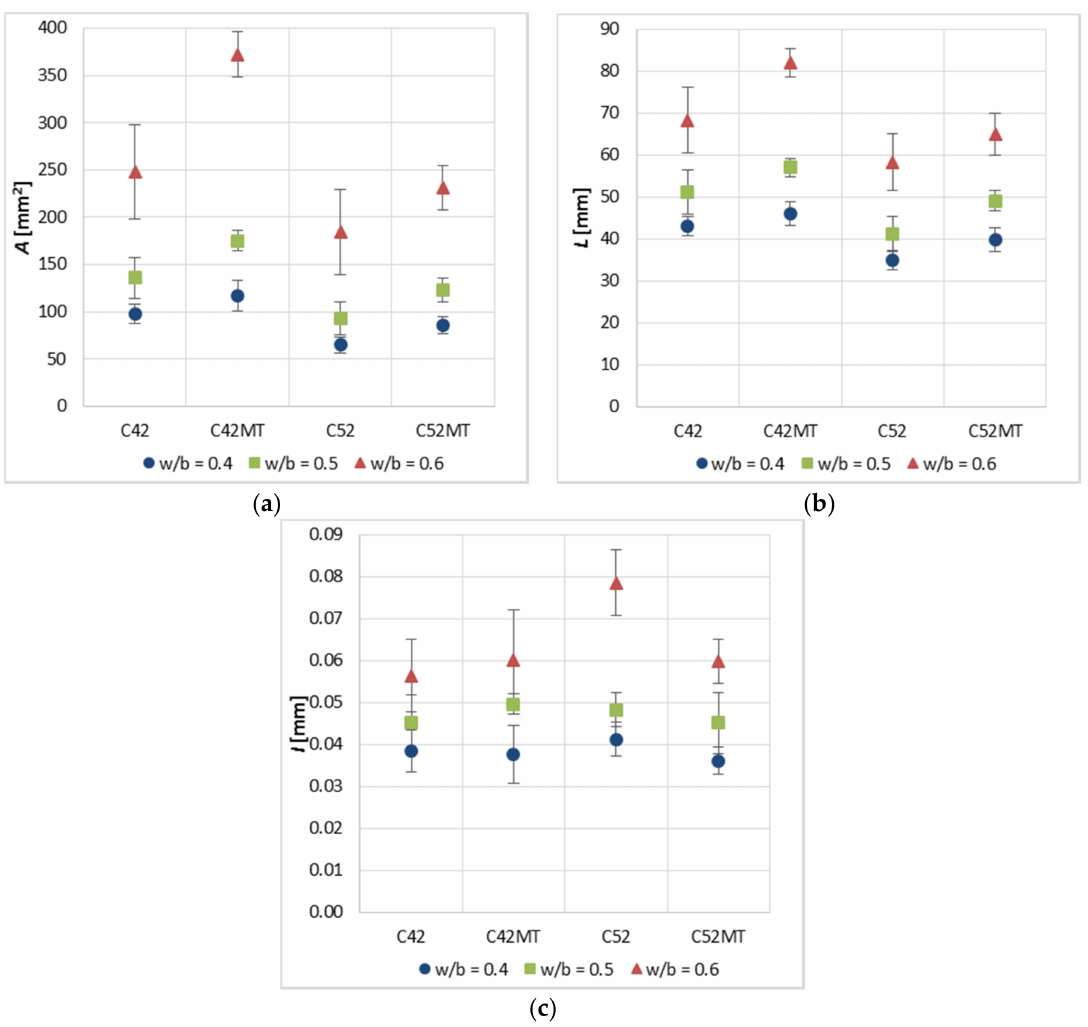
Figure 6. Results of the image analysis of the cement paste surface (error bars mean standard deviations): ( a ) the cluster average area— A ; ( b ) the cluster average perimeter— L ; ( c ) the crack average width— I